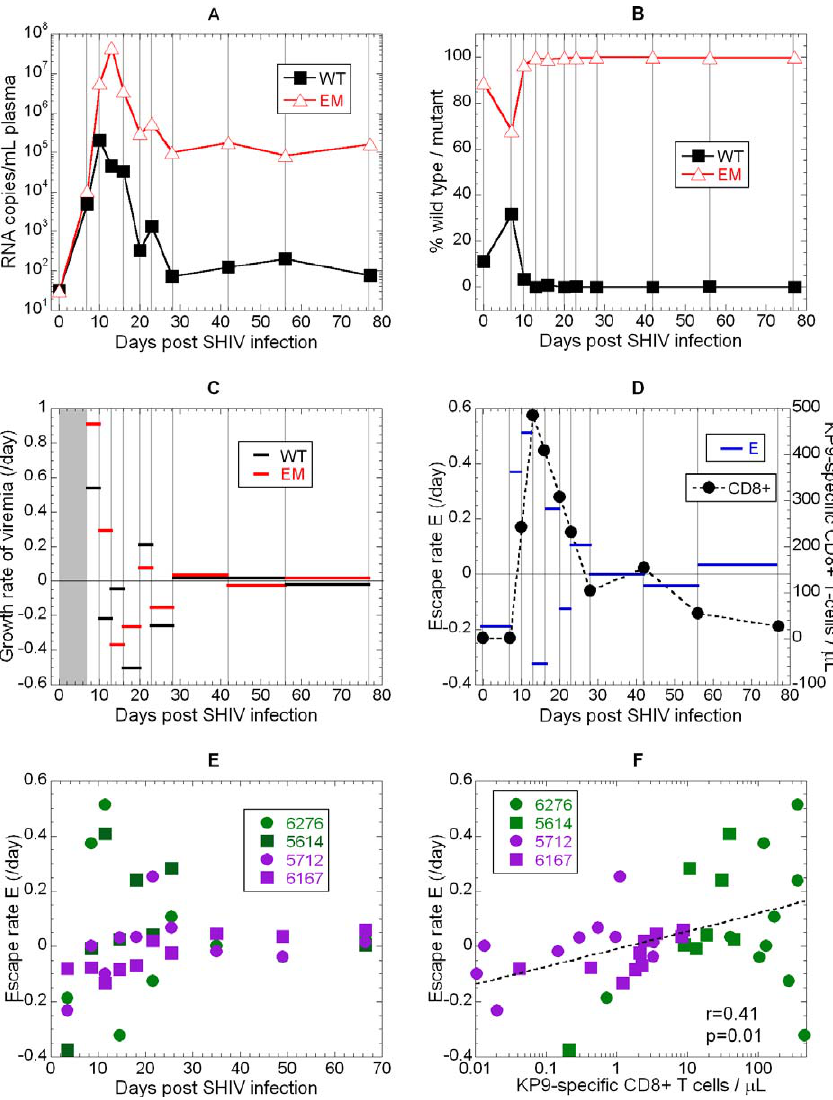
Figure 6. Early Reversion and Re-Escape Rates at the KP9 Epitope The levels of KP9 wild-type and escape mutant in a representative animal (#6276) following infection with the SHIV mn229 virus (containing 11.2% WT and 88.8% EM virus) (A). The fraction (B) and growth rates (C) of WT and EM virus over time are also shown. The rate of escape (D) is negative immediately after infection (as the WT virus takes over, prior to CTL effects) Growth rates could not be evaluated during the first week because the viral loads at day 0 were below detection (grey rectangle in [C]), but we calculated the difference in growth rates rate from the known percentages in the inoculum. (E) The variation of escape rate with time is shown for the different animals that were either vaccinated (green symbols) or unvaccinated (purple symbols). (F) The rate of escape is significantly correlated with the number of KP9 responding CTLs detected by the KP9/Mane-A*10